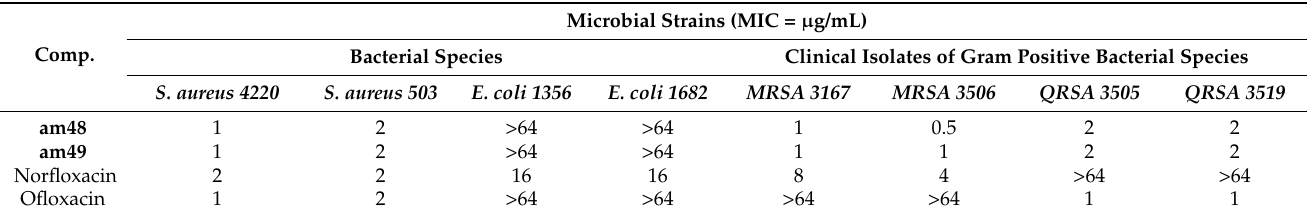
Table 22. Inhibitory activity (MIC, µ g/mL) of the compounds am48 and am49 against the bacteria and clinical isolates of multidrug-resistant Gram-positive strains.